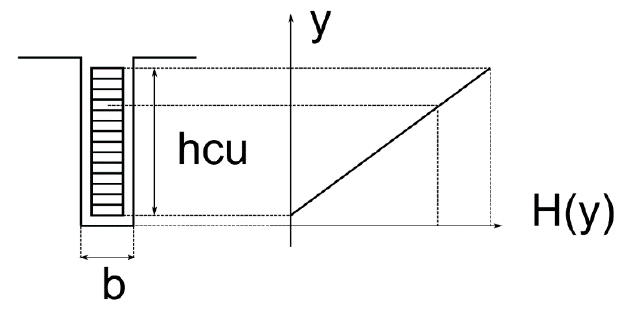
Figure 7. H fields in the bar.